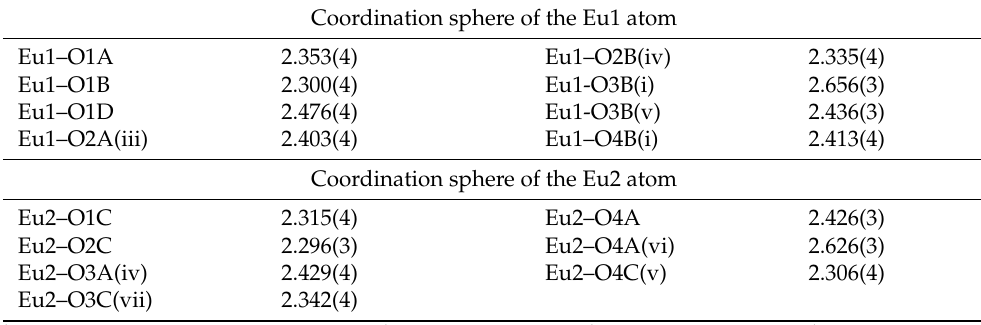
Table 2. Selected bond lengths for compound 2 Eu (Å) 1 .